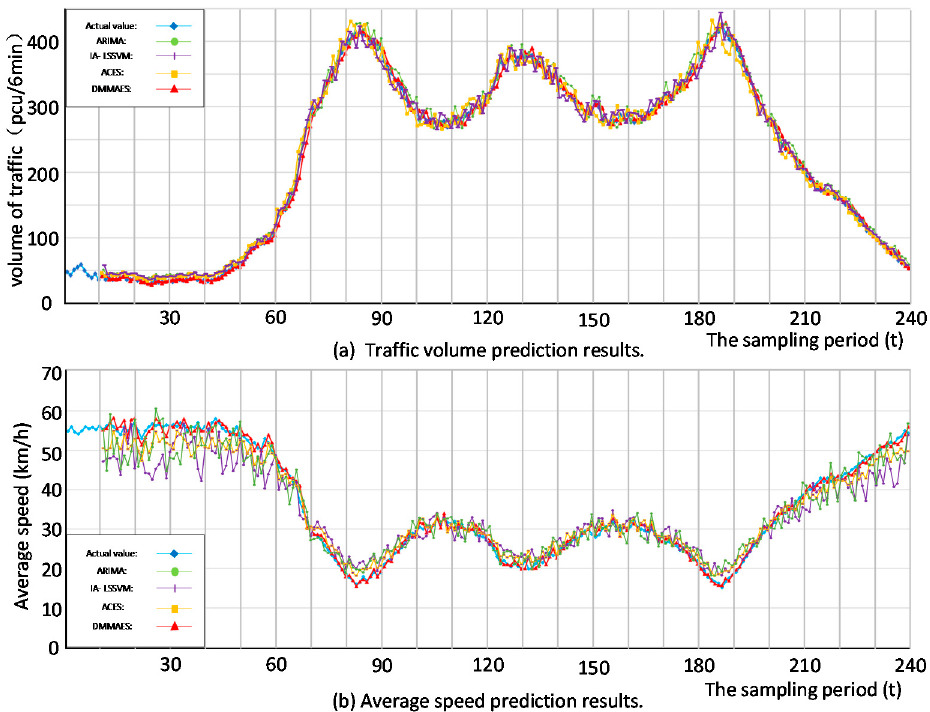
Figure 10. Traffic volume, f , and average speed, v i , prediction results.